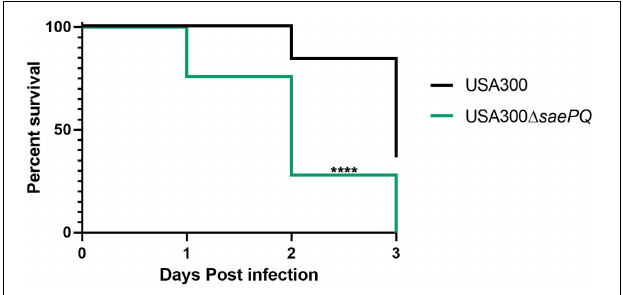
FIGURE 6 | Deletion of saePQ enhances the virulence in S. aureus in a mouse model of systemic infection. Survival curves for C57BL/6 mice ( n = 13/group) challenged with either 1 × 10 7 CFU S. aureus or USA300 or USA300 (cid:49) saePQ via tail vein injection. Data shown are death from infection and euthanasia (for exceeding scores on the welfare rubric) during the 72 h endpoint. Data are from two independent experiments. **** P < 0.0001, log-rank (Mantel-Cox)